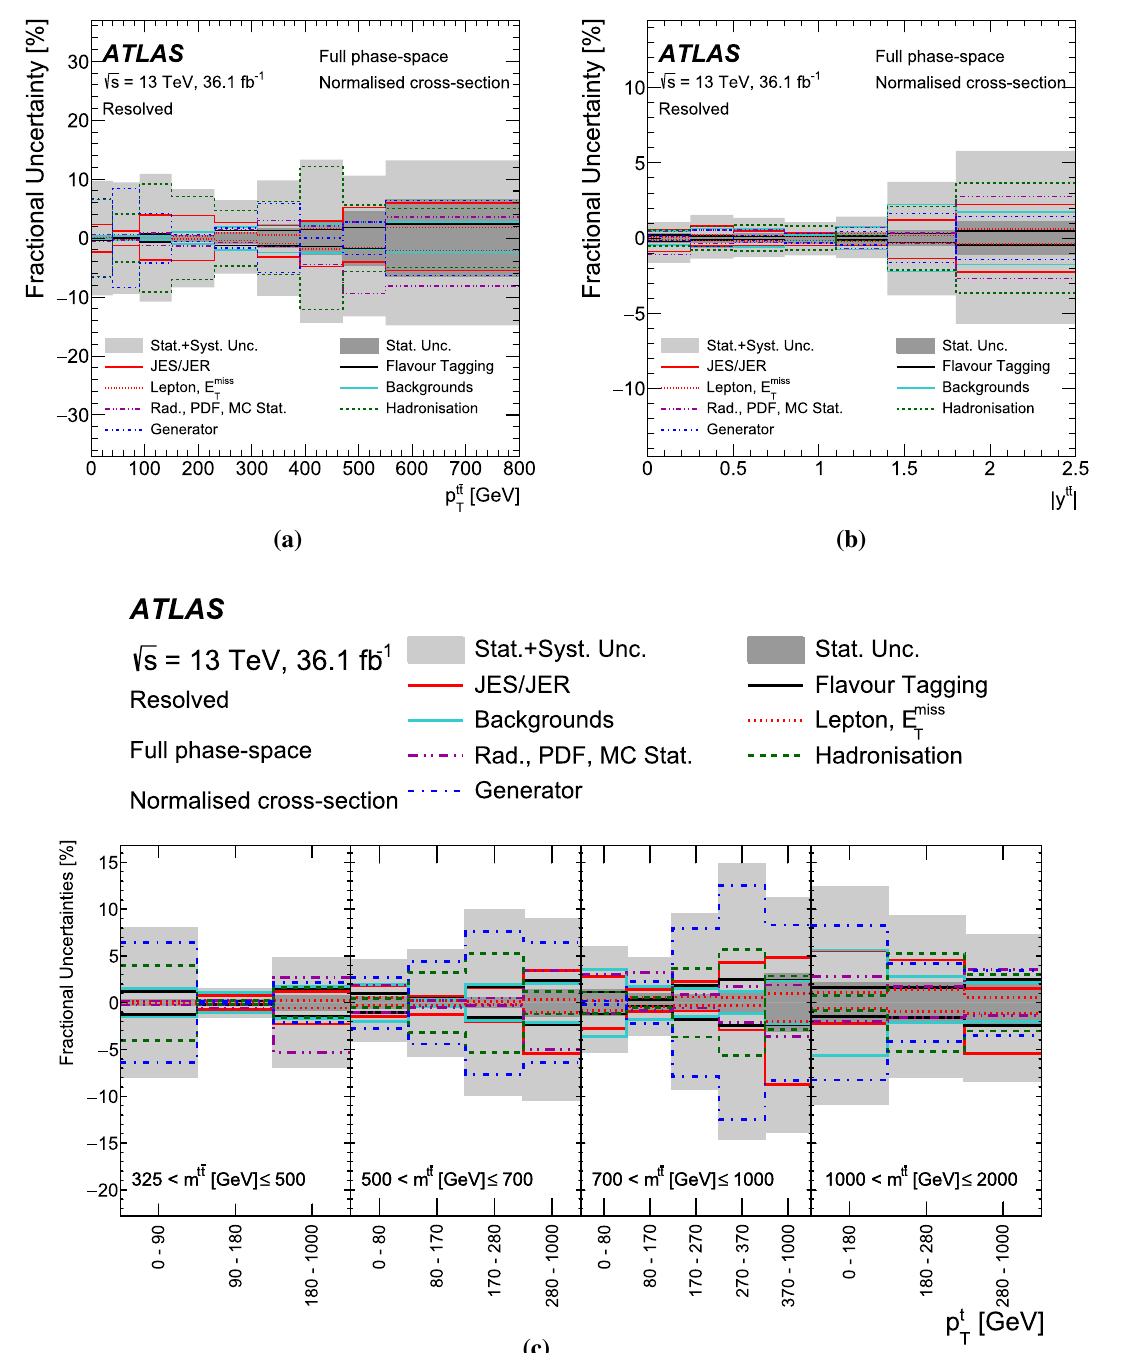
Fig. 20 Uncertaintiesintheparton-levelnormaliseddifferentialcross- sections as a function of a the t ¯ t system transverse momentum b the absolute value of the rapidity and c the transverse momentum of the top